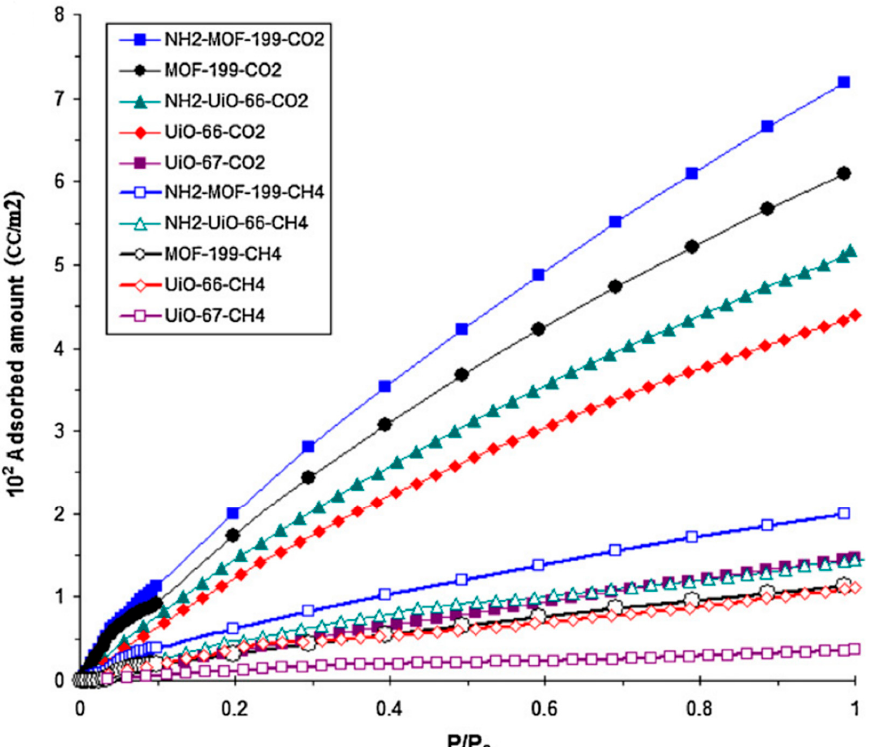
Figure 4. CO 2 and CH 4 adsorption isotherms of NH 2 -MOF-199, NH 2 -UiO-66, MOF-199, UiO-66, and UiO-67 reported by Nik et al. [83].